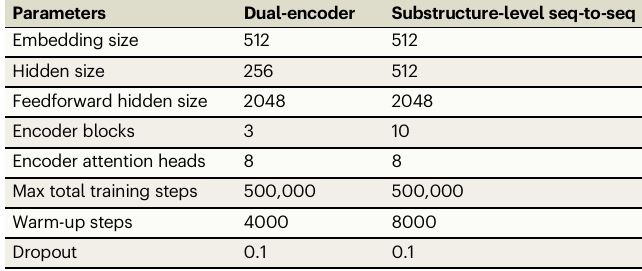
Table 2 | Transformer parameter settings in the dual-encoder and the substructure-level sequence-to-sequence model